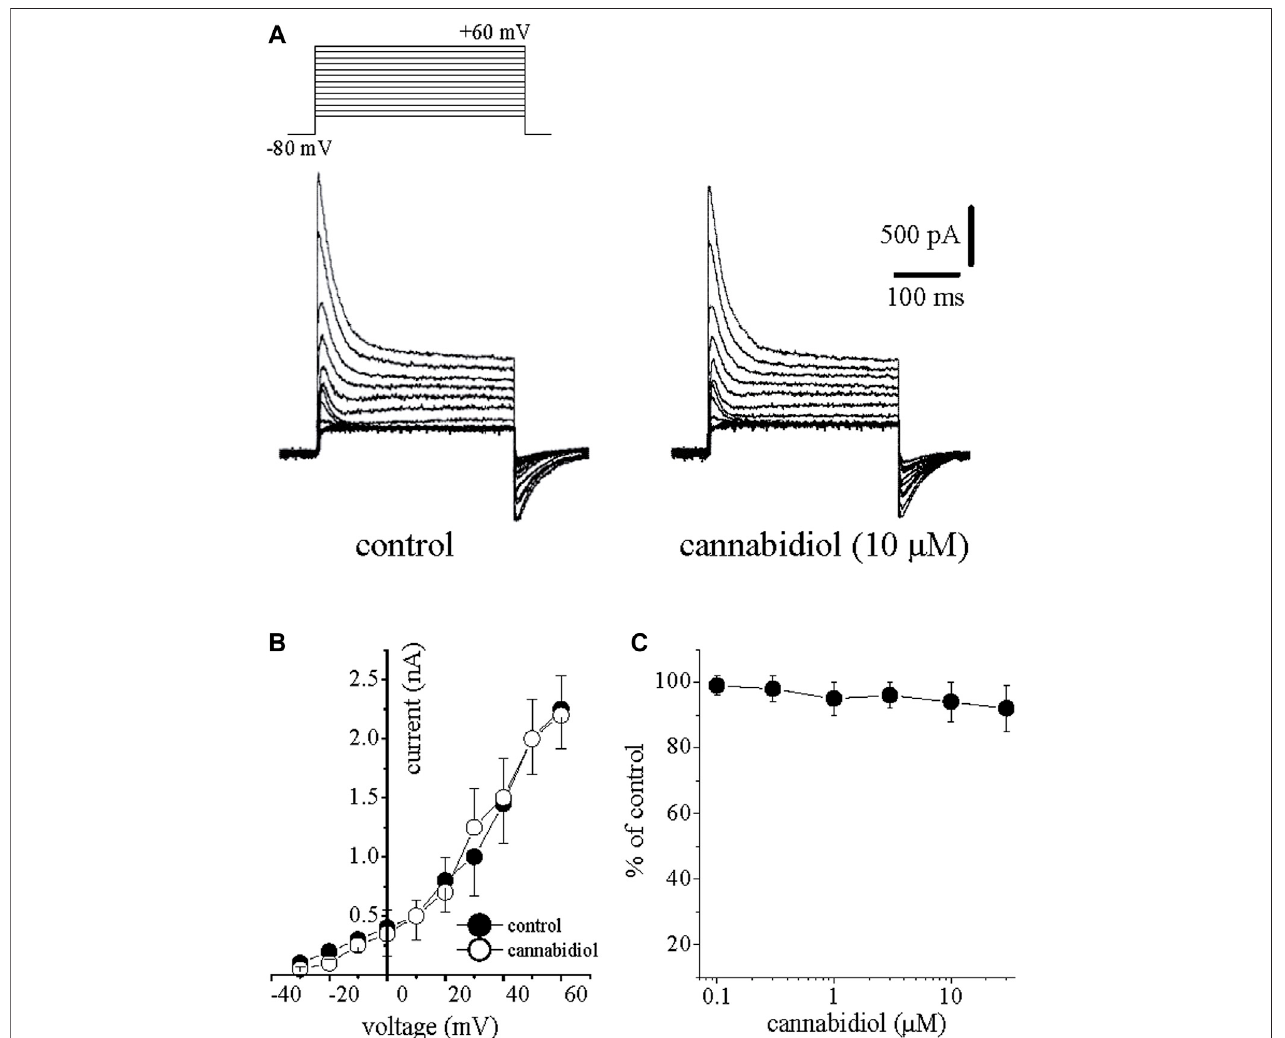
FIGURE 5 | The effects of cannabidiol on the transient outward I to in rabbit ventricular myocytes (A) Original traces of I to obtained in response to incremental depolarizations from a holding potential of − 80 mV up to +60 mV are presented in controls (on the left) and after 10 min exposure to 10 μ M CBD. The pulse protocol to activate I to ispresentedintheinset (B) Averagesofcurrent-voltagerelationof I to intheabsence( fi lledcircles)andpresenceofCBD(opencircles)arepresented(n (cid:1) 6) (C) The effect of increasing CBD concentrations on I to (n (cid:1) 4 – 6).